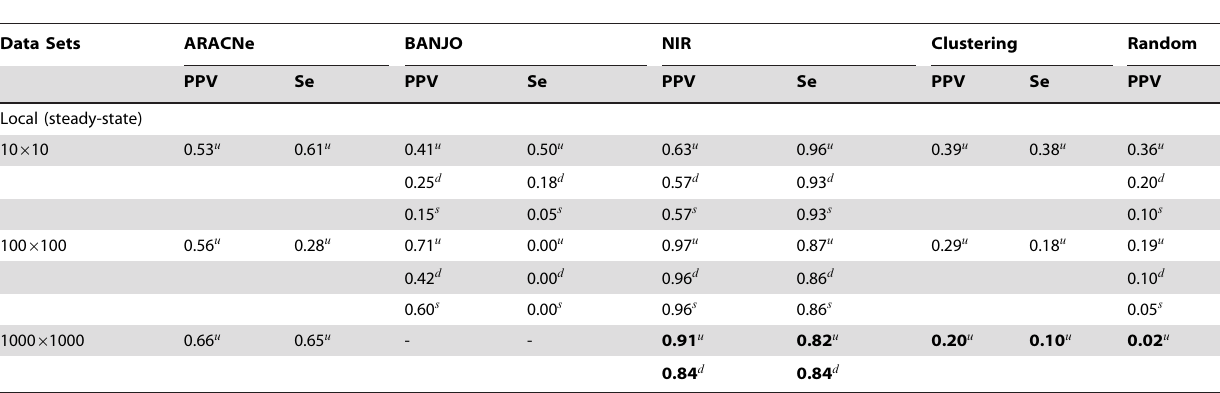
Table 1. Results of the application of network inference algorithms on the simulated dataset.